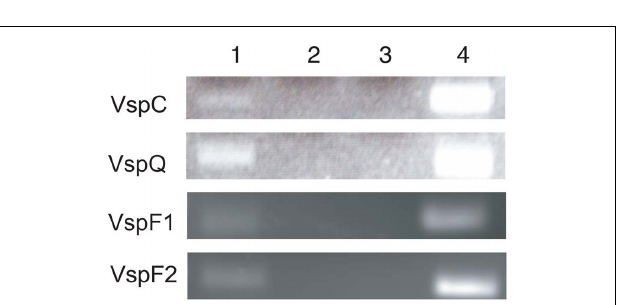
pneumoniae .The latter is included because the chlamydiae are generally considered to be more phylogenetically related to the Verrucomicrobia than other phyla. Genes are colored to correspond to the protein components depicted in part (A) of the figure. Double vertical lines indicate that theT3SS genes are not immediately adjacent to each other in the respective genomes.